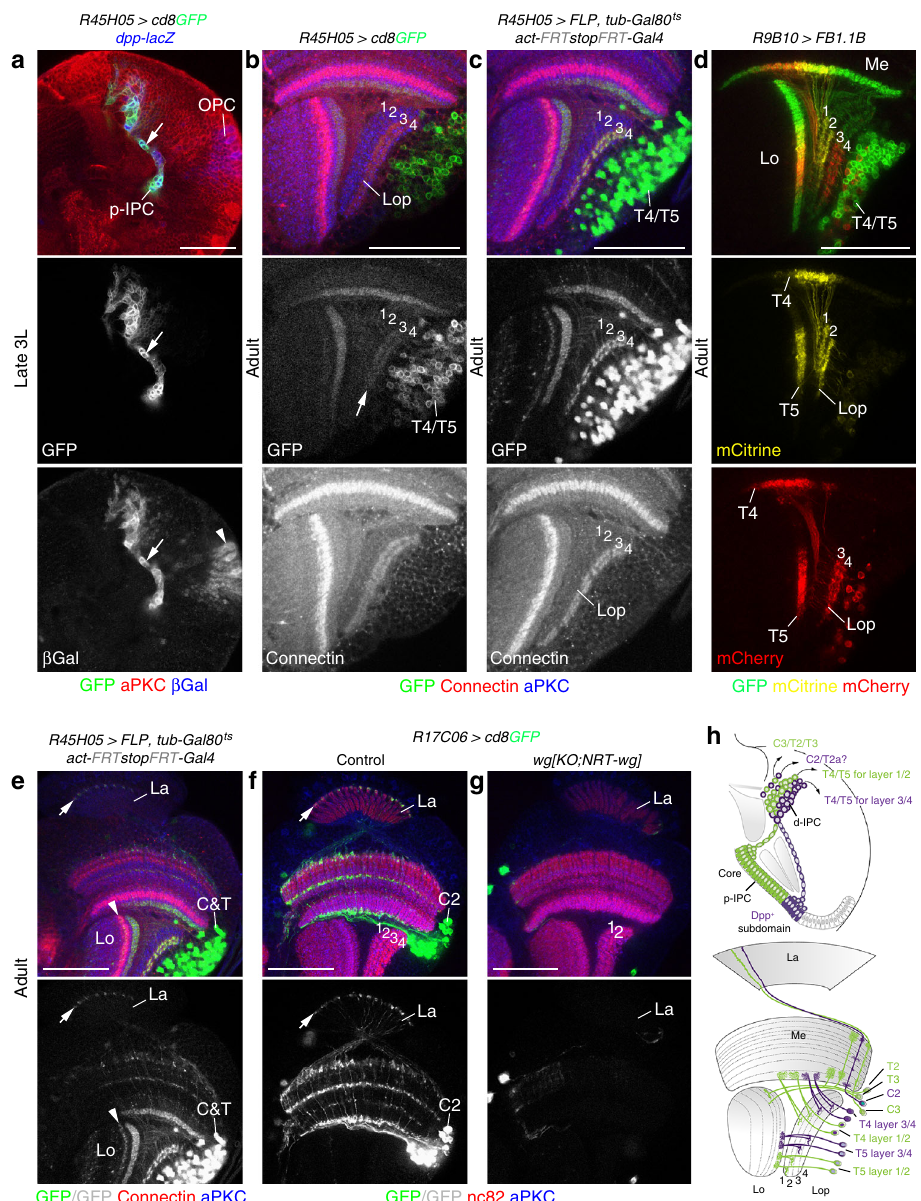
Fig. 4 The Dpp-expression domain generates C2 and T4/T5 neurons for layers 3/4. a R45H05-Gal4 UAS-cd8GFP (green) colocalizes with the dpp-lacZ (blue) expression domain in the IPC (arrow) but not the OPC (arrowhead) in 3rd instar larvae (3L). b R45H05-Gal4 UAS-cd8GFP (green) was weakly maintained in T4/T5 neurons innervating Connectin-positive lobula plate (Lop) layers 3/4 (red, arrow) in adults. c Permanent GFP-labeling (green) of the R45H05-Gal4 expression domain using act>y + >Gal4 UAS-GFP , UAS-FLP , and tub-Gal80 ts was speci fi c to T4/T5 neurons innervating lobula plate layers 3/4. d R9B10-Gal4 in conjunction with Flybow transgenes labeled T4/T5 neuron clones either innervating lobula plate (Lop) layers 1/2 (mCitrine, yellow) or 3/4 (mCherry, red). e Permanent GFP labeling (green) with R45H05-Gal4 included C2, as well as T2a and/or T3 neurons with characteristic axon terminals in the lamina (La, arrow) and lobula (Lo, arrowhead). f , g Unlike in controls ( f ), C2 neuron-speci fi c R17C06-Gal4 UAS-cd8GFP expression (green) with axon terminals (arrow) in the lamina (La) was absent in wg{KO;NRT-wg} fl ies that had two remaining lobula plate layers ( g ). h Schematics illustrating the neuron subtypes derived from the Dpp-expression domain and the core p-IPC in 3rd instar larvae and adults. For genotypes and sample numbers, see Supplementary Table 1. Scale bars, 50 μ to the d-IPC, phospho-Mad (pMad) labeling was restricted to p- IPC NE cells (Fig. 7a). Consistently, knockdown experiments using Gal4 lines with progressively restricted activities (Supple- mentary Fig. 7a – c) revealed a requirement of tkv for layer 3/4 neuron formation in p-IPC NE cells (cf. Fig. 3n), but not in d-IPC additional mechanism must relay Dpp signaling activity in p-IPC